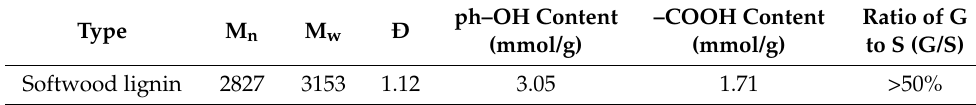
Table 1. The parameters obtained for the as-purchased lignin. Type M n M w Ð Softwood lignin 2827 3153 1.12 3.05 1.71